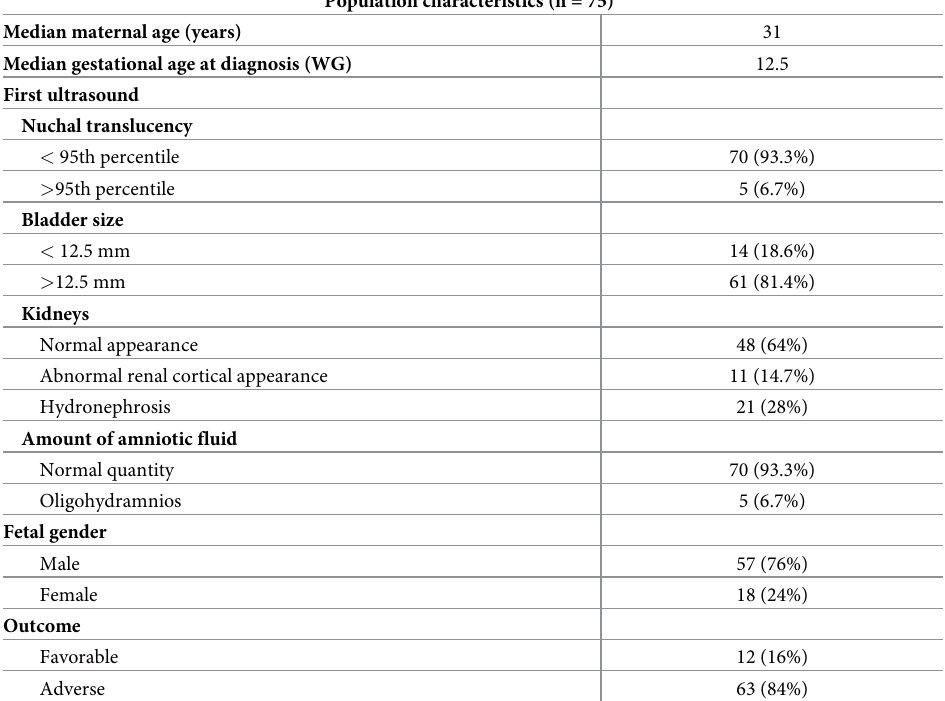
Table 1. Population